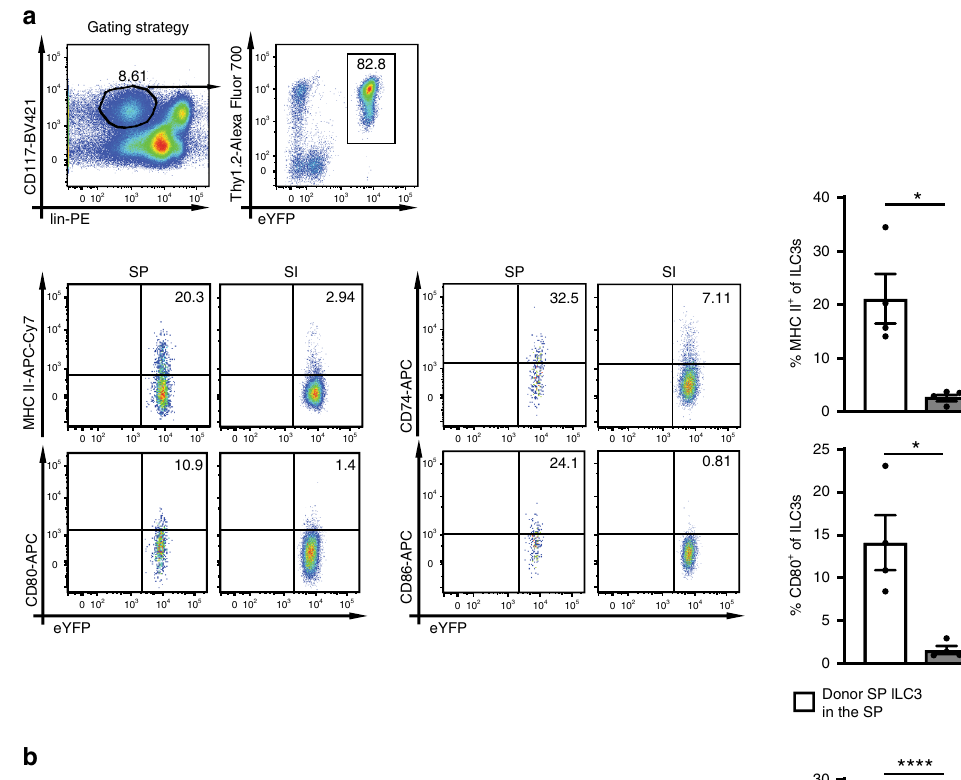
altered by environmental signals, SP and SI ILC3s from Ror γ t fm + Rag2 − / − mice were adoptively transferred into Rag2 − / − Il2rg − / − mice. Five weeks after transfer, eYFP + donor ILC3s isolated from the SP and the SI of recipient mice were analyzed for the expression of CD80, CD86, CD74, and MHC II. There was no tissue-origin-speci fi c bias of ILC3s homing to SP and SI.